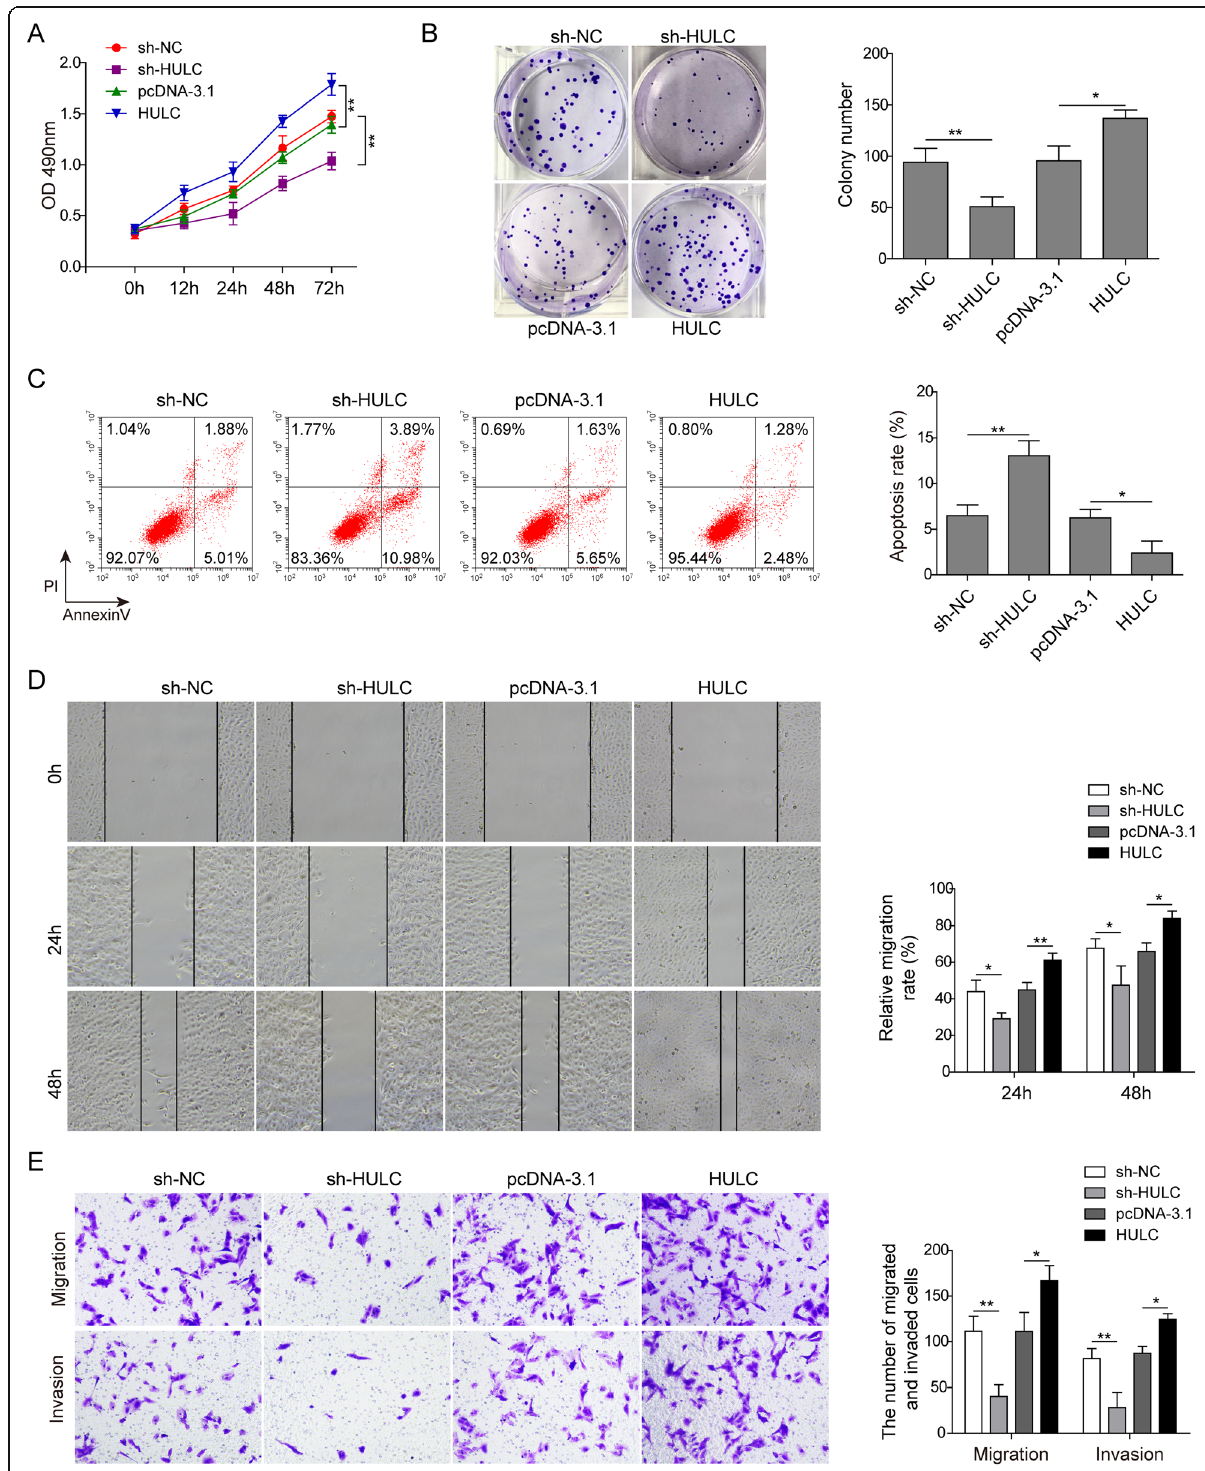
Fig. 2 HULC knockdown inhibited the proliferation, migration and invasion of osteosarcoma cells in vitro. U2OS cells were transfected with HULC-targeting shRNA (sh-HULC), negative control shRNA (sh-NC), pcDNA3.1-HULC overexpression vector (pcDNA-HULC) or empty vector plasmid (pcDNA-3.1). Cell proliferation was tested by CCK-8 assay (A) and colony formation assay (B); cell apoptosis was analysed by flow cytometry (C); and cell migration and invasion were detected by wound healing assay (D) and transwell assay (E). Data are shown as the mean ± SD. * p < 0.05, ** p <